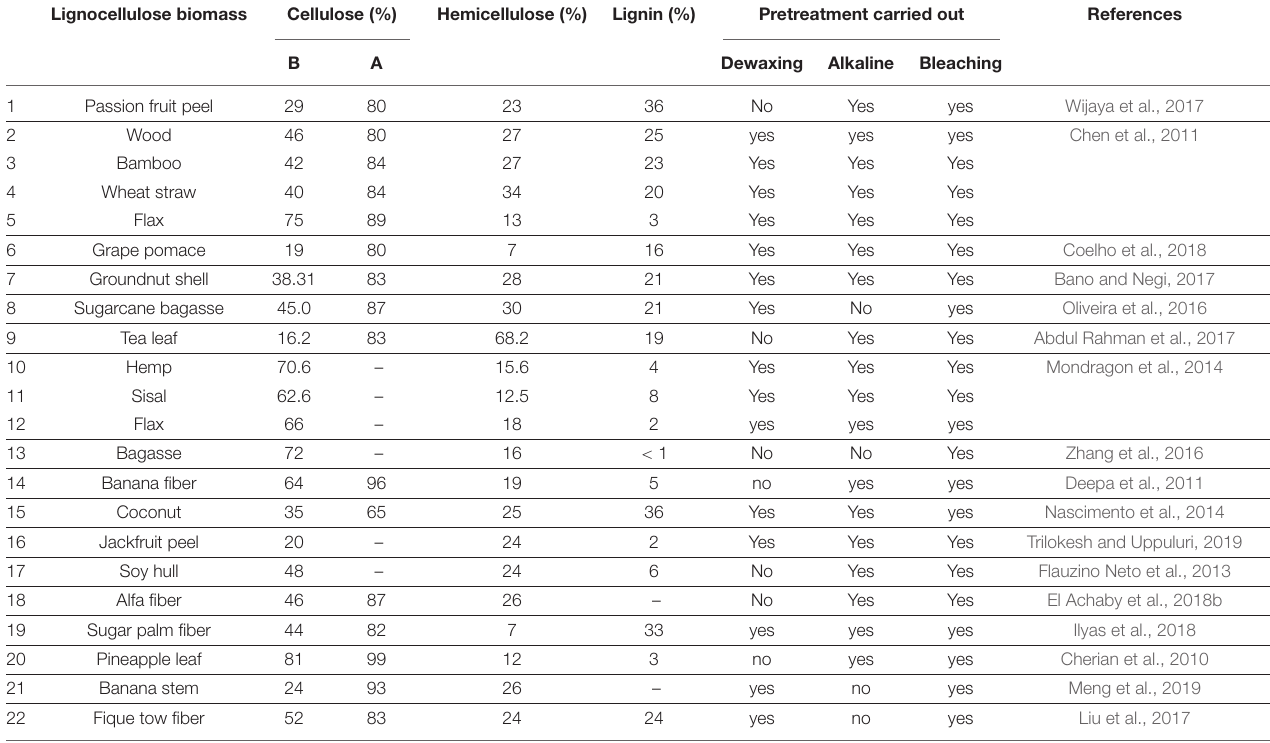
TABLE 2 | Percentage composition of selected lignocellulose biomass and procedures use to obtain higher cellulose content. Lignocellulose biomass Cellulose (%) Hemicellulose (%) Lignin (%) Pretreatment carried